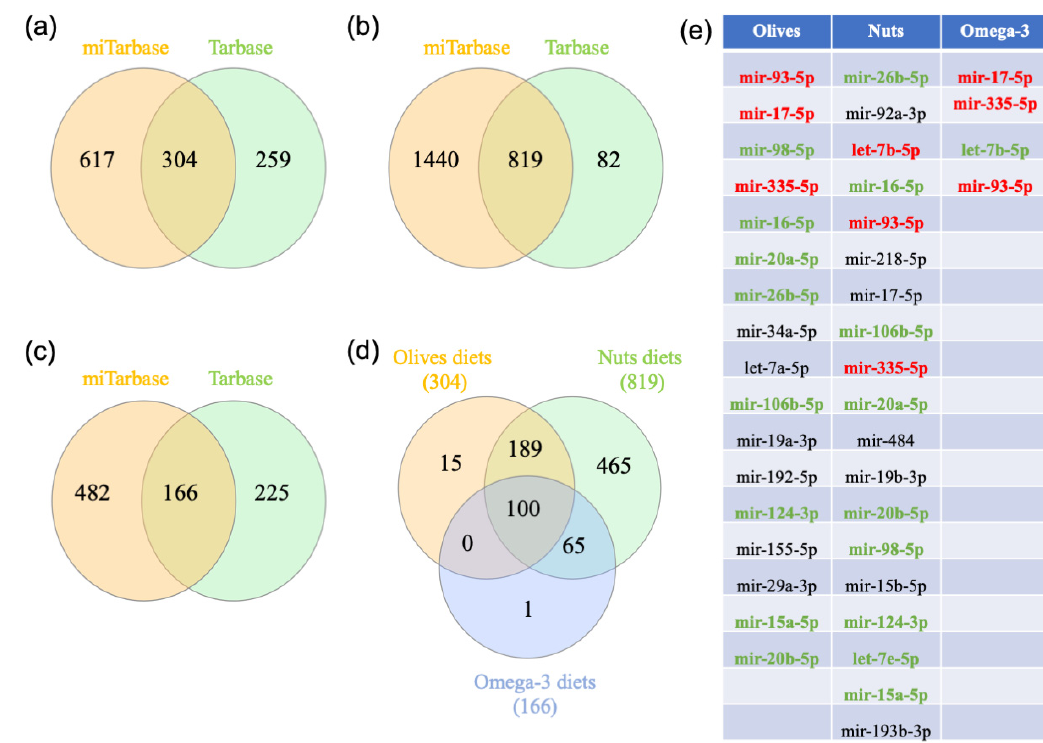
Figure 5. MicroRNA analysis. The diet gene lists were uploaded to https: // www.networkanalyst.ca / NetworkAnalyst / faces / home.xhtml. A gene-microRNA interactome was performed using the TarBase and miRTarBase databases. ( a ), ( b ), and ( c ) represent the results of the Venn analysis performed with olive-, nuts- and omega-3-genes, respectively. ( d ) The miRNA shared between the three types of Mediterranean diets were analyzed in a Venn diagram analysis. The most significant miRNAs are listed in ( e ). MiRNAs in red are shared between the 3 supplements, the miRNAs in green are shared between 2 supplements, and the miRNAs in black are unique to a supplement.